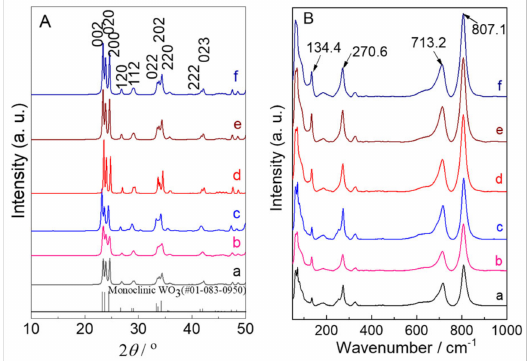
Figure 3. ( A ) XRD patterns and ( B ) Raman spectra of (a) WO 3 − 0, (b) WO 3 − 0.62, (c) WO 3 − 1.2, (d) WO 3 − 2.5, (e) WO 3 − 5, and (f) WO 3 − 7.5,